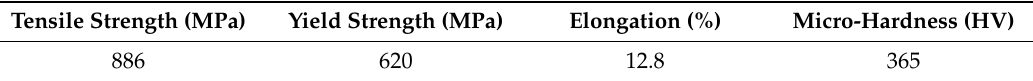
Table 2. Mechanical properties of Ti-24Al-15Nb alloy at ambient temperature.